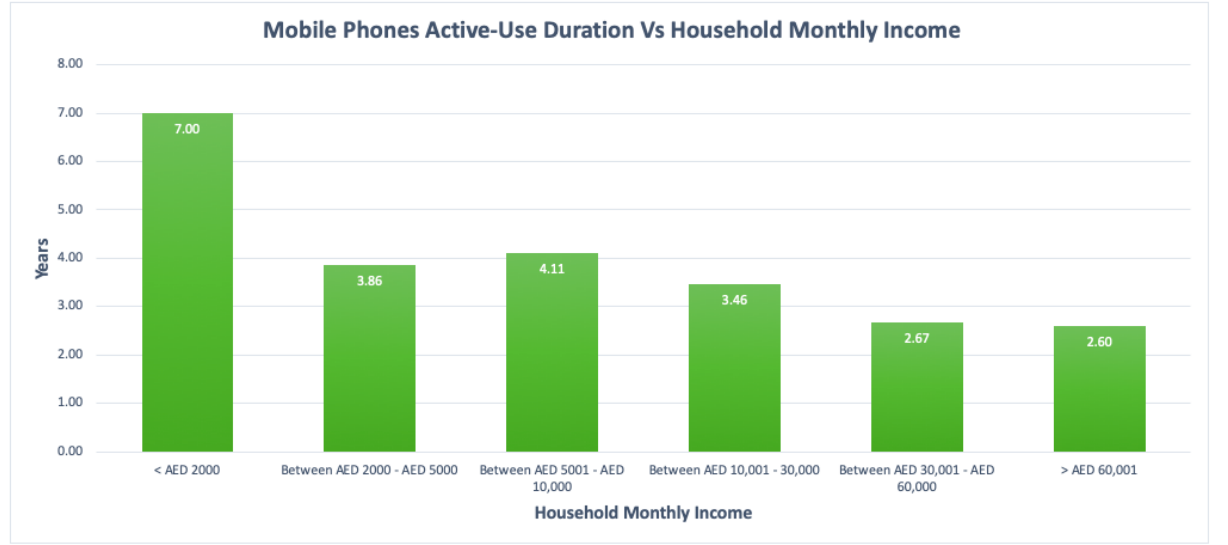
Figure 16. Active-use duration Versus Household monthly income.